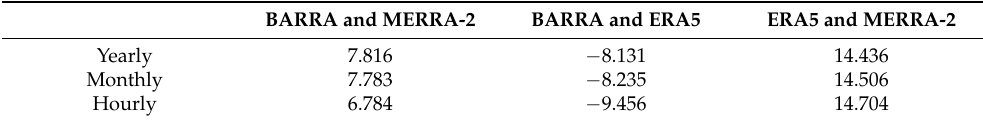
Table 5. Average percentage difference (%) between capacity factors predicted using each dataset at key